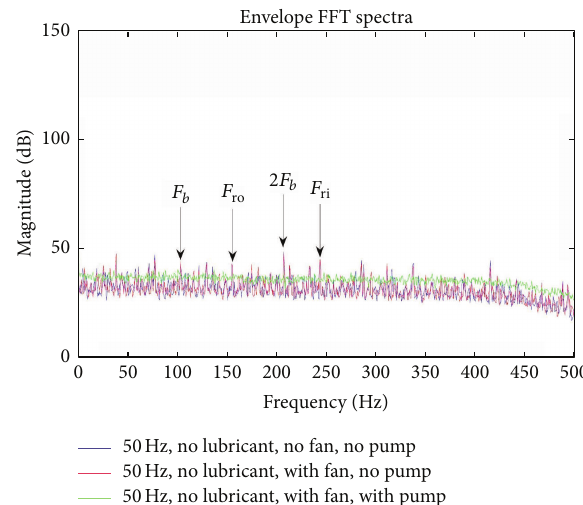
Figure 11: Generalized roughness spectra of 50 Hz motor input, different load conditions (free load, fan load, and pump load), and radial vibration measurements.